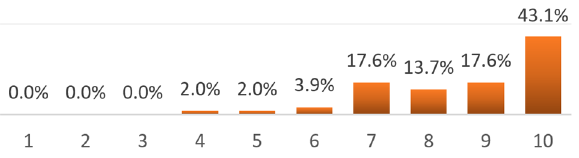
Figure 14. Can the use of such or similar teaching tools help in learning statics? (1—no, 10—yes, very much).